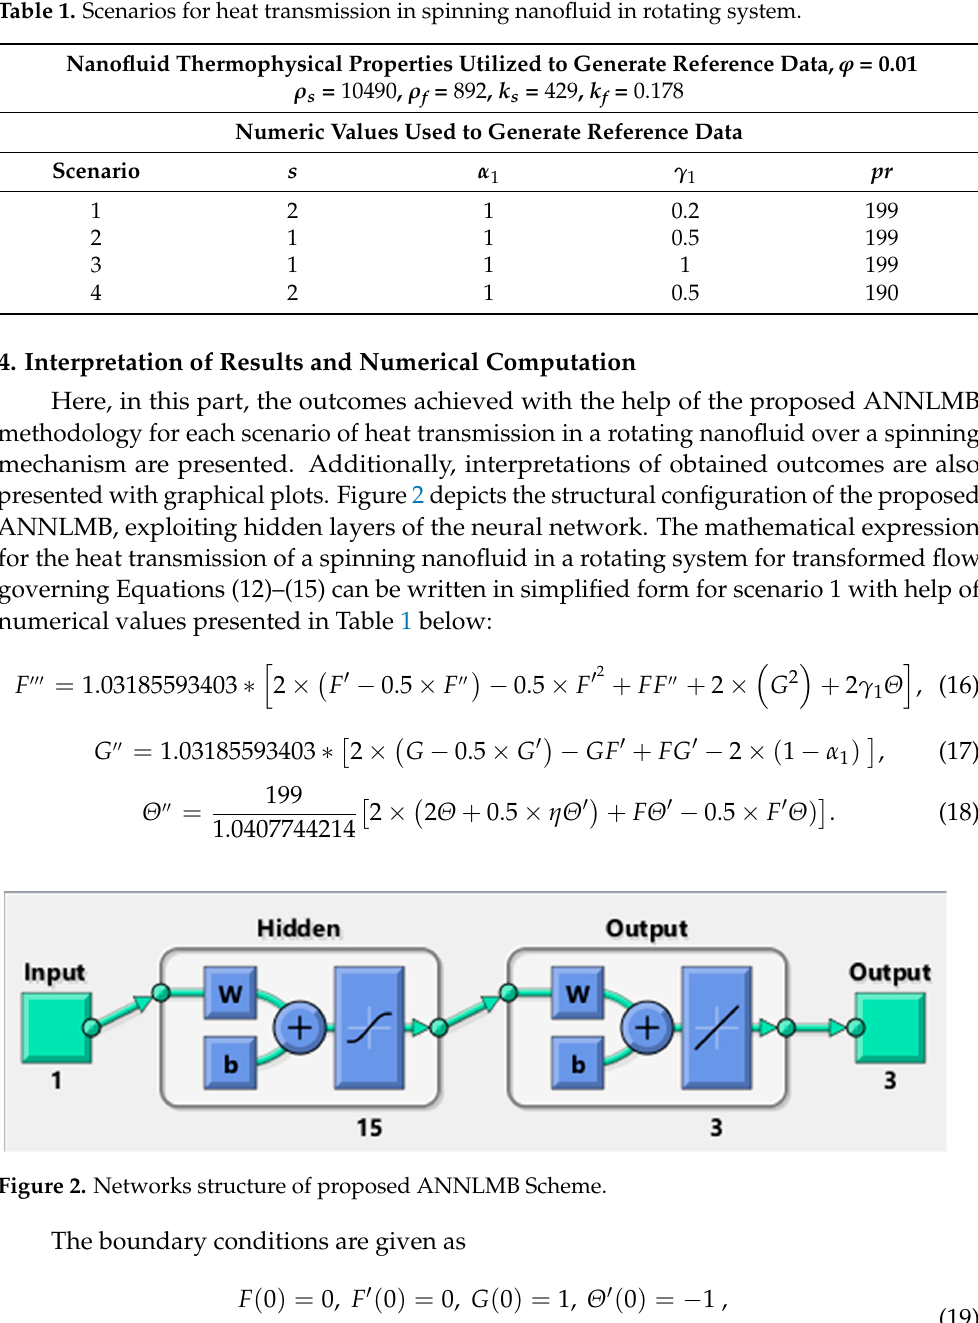
Table 2. Comparison of Nusselt number (𝑁𝑢 (cid:3051) ) with already published work of Hussain et al. [19]. Raju and Sandeep [31].